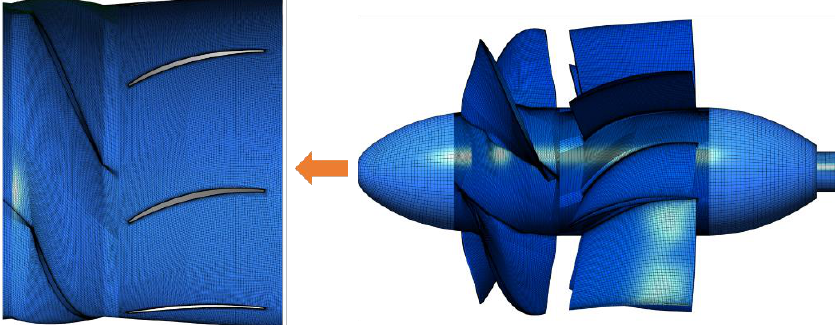
Figure 2. The grid model of the main calculation domains. Table 1. Mesh schemes and corresponding external characteristics.